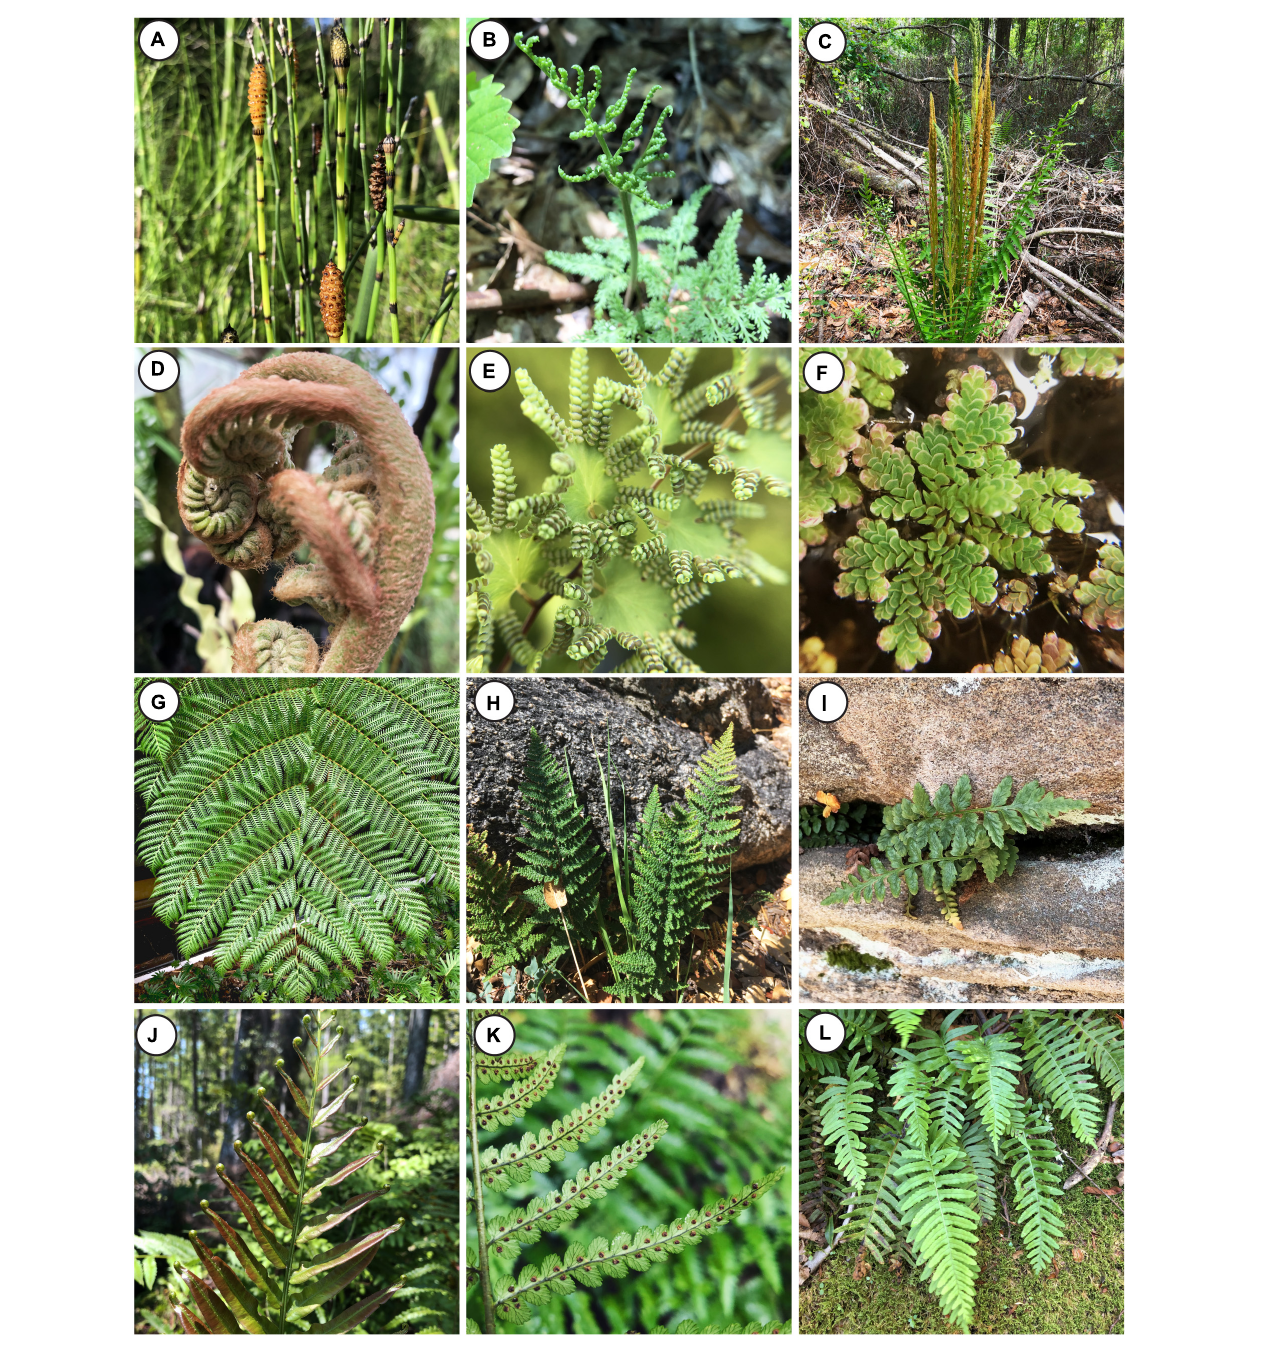
FIGURE 1 | The diversity of ferns. (A) Equisetum hyemale (Equisetaceae, Equisetales), (B) Sceptridium dissectum forma dissectum (Ophioglossaceae, Ophioglossales), (C) Osmundastrum cinnamomeum (Osmundaceae, Osmundales), (D) Angiopteris evecta (Marattiaceae, Marattiales), (E) Lygodium microphyllum (Lygodiaceae, Schizaeales), (F) Azolla filiculoides (Salviniaceae, Salviniales), (G) Sphaeropteris cooperi (Cyatheaceae, Cyatheales), (H) Myriopteris wootonii (Pteridaceae, Polypodiales), (I) Asplenium hybrid (Aspleniaceae, Polypodiales), (J) Telmatoblechnum serrulatum (Blechnaceae, Polypodiales), (K) Dryopteris ludoviciana (Dryopteridaceae, Polypodiales), (L) Polypodium virginianum (Polypodiaceae, Polypodiales). All images by JP.